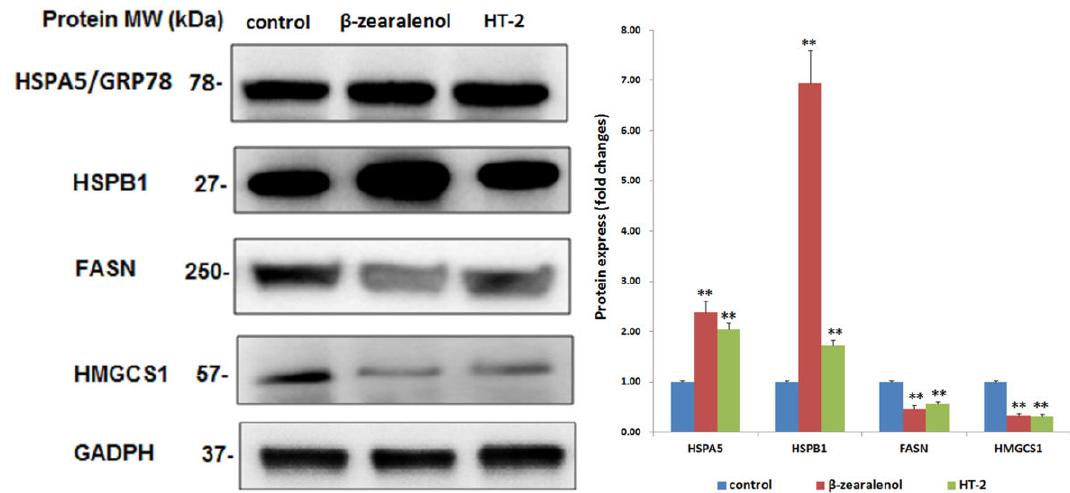
Figure 4. Western blotting analysis of the expression of heat shock proteins (HSPs) (HSPA5 and HSPB1) and other genes (FASN and HMGCS1) in the GCs. GADPH was used as a sample loading control. Values represent the mean ± S.D. ** p < 0.01 versus that of the control group. Table 1. E ff ects of mycotoxins ( β -zearalenol or HT-2) on the expression of selected genes involved in the heat shock protein family (fold changes ≥ 1.5- or ≤ 0.67-fold). HSP